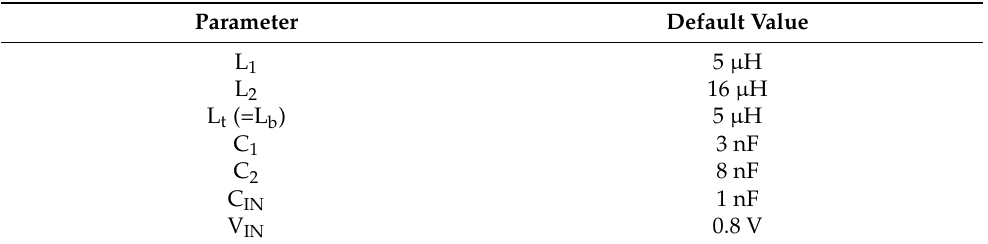
Table 1. Nominal condition to validate the models proposed in Section 3 with SPICE simulation.